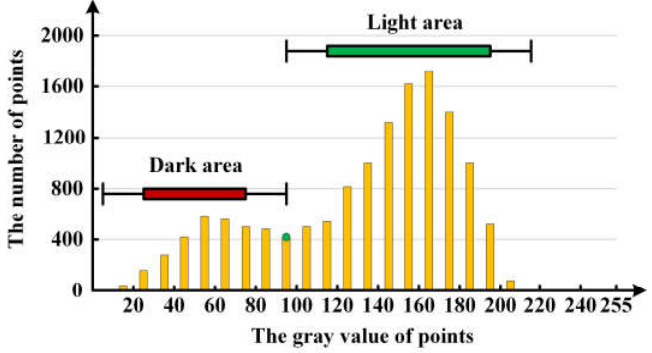
Figure 6. Distribution of gray values of points in the voxels. Step 4: Determination of light and shadow. As shown in Figure 7a, a light beam leaves shadows on the cracks and sheltered places on a rock mass’s surface. The cracks are effective discontinuity traces, and the shadow boundaries caused by occlusion are invalid. Therefore, we needed to eliminate invalid shadow boundaries.